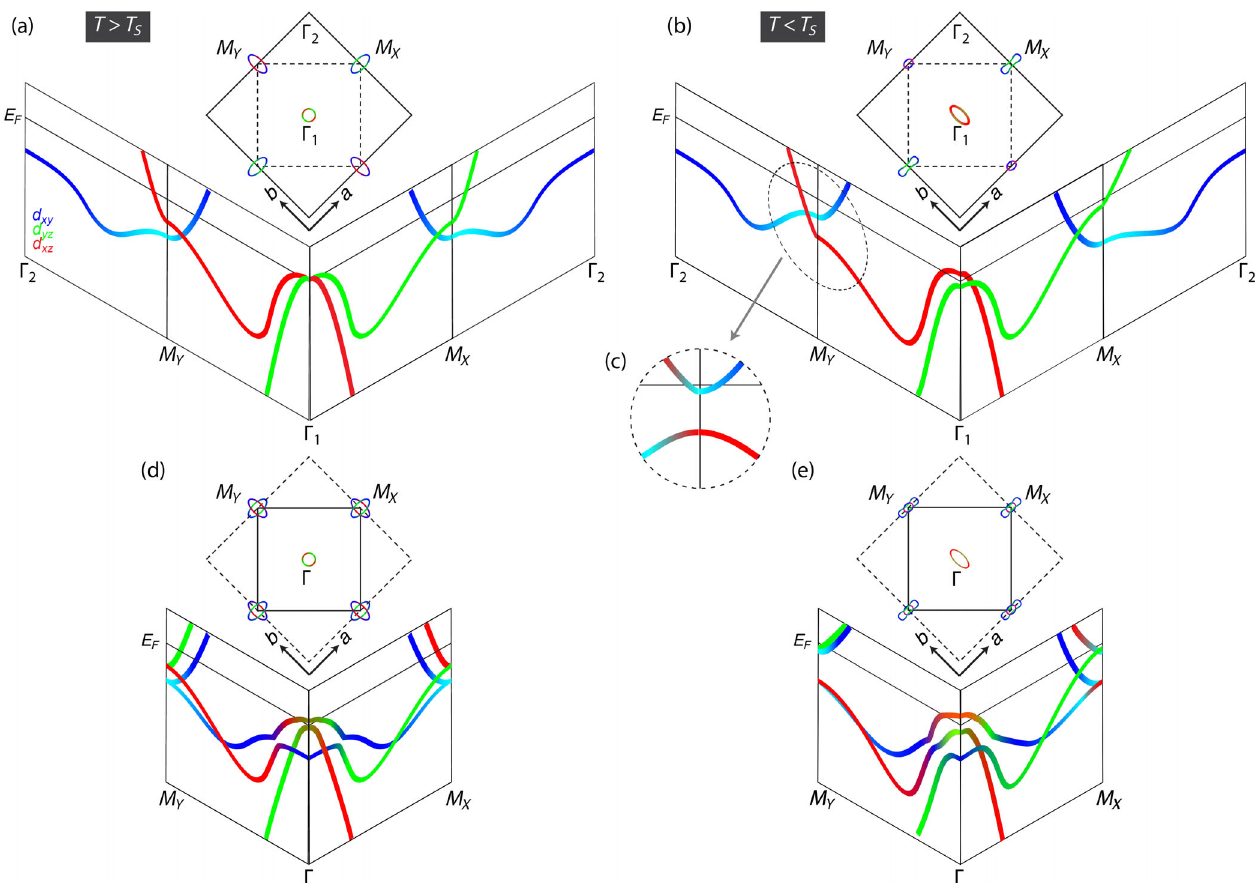
FIG. 5. Schematic of the nematic band reconstruction. (a),(b) Summary of the band structure in the tetragonal (a) and orthorhombic (b) phases in the unfolded 1-Fe BZ. Band hybridizations and the effect of spin-orbit coupling (SOC) are omitted for simplicity. (c) Note that, at M Y in the nematic phase, the downshifted d xz band crosses the d xy band, opening up a hybridization gap. (d),(e) Summary of the band structure in the tetragonal and orthorhombic phases in the folded 2-Fe BZ. Band hybridizations and SOC are incorporated here for a direct comparison to the data. The colors correspond to d xz (red), d yz (green), and d xy (blue, with cyan marking portions with weak photoemission matrix